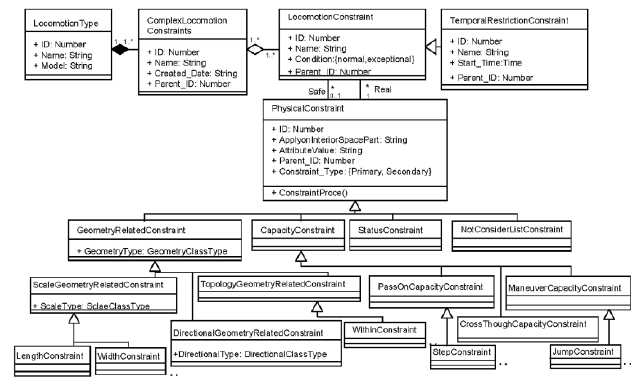
Figure 7. Conceptual model of constraints according to locomotion type (Khan and Kolbe,